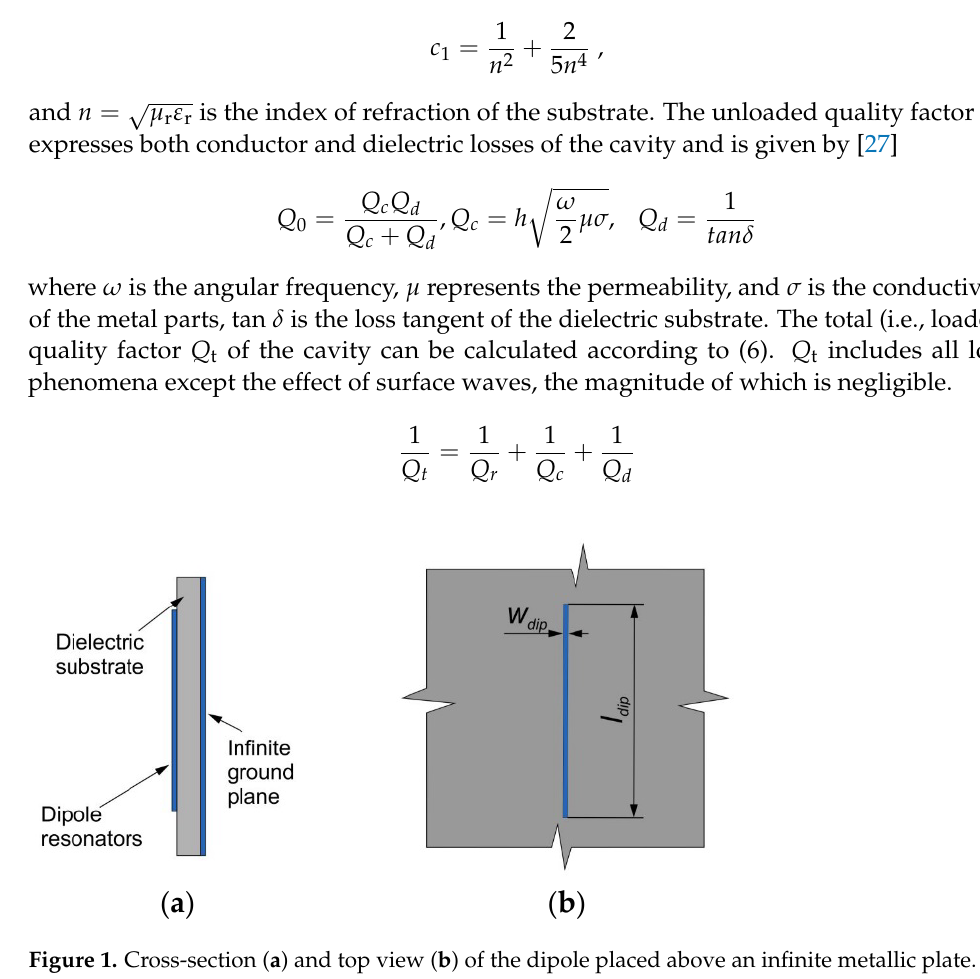
( b ) Figure 2. Quality factors vs. height of ( a ) a narrow dipole 46 × 0.2 mm 2 and ( b ) a wide dipole 46 × 1 mm 2 situated on a foam substrate above an infinite metallic plane for conductivity of copper (5.8 × 10 7 S/m) and silver paste (1.6 × 10 6 S/m). Intersection of the Q 0 and Q r curves correspond to critical coupling and deep resonant minima on the RCS curve.